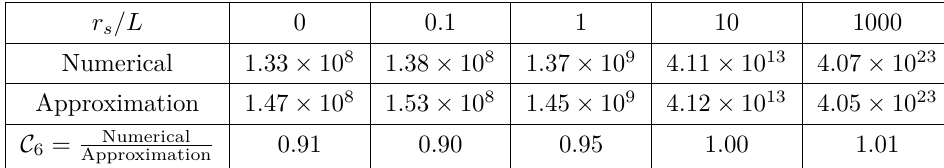
Table 4 . d = 6 and δr/r s = 10 − 4 .